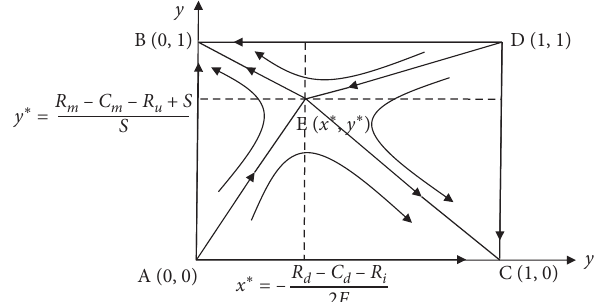
Figure 8: The replication dynamic phase map for scenario (14).